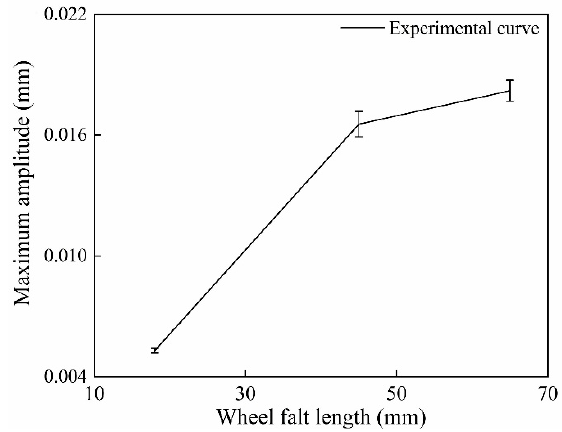
Figure 17. The error curve of the wheel flat. Table 2. Wheel flat measurement results.